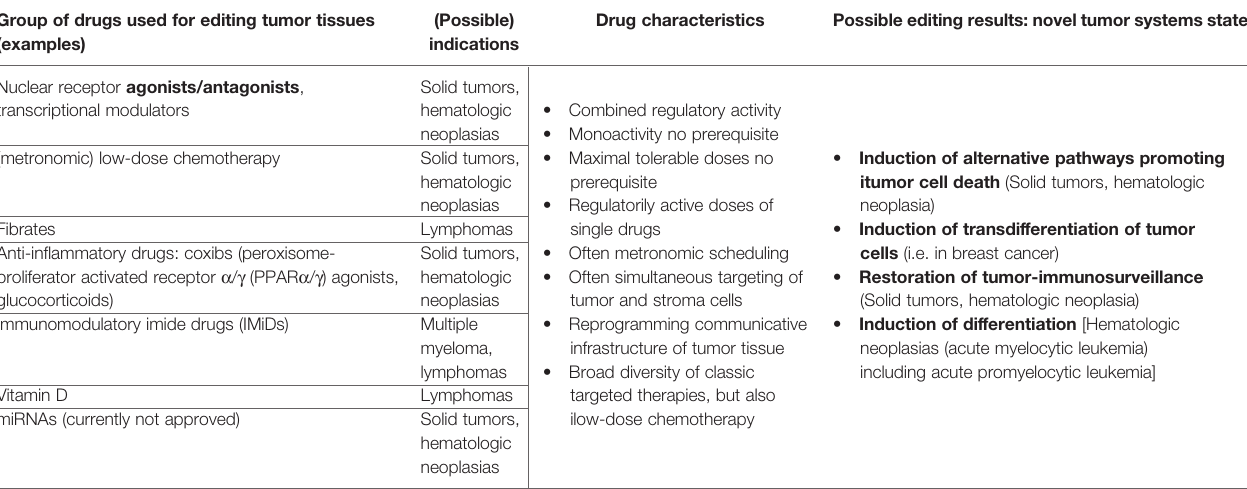
TABLE 1 | Drug repurposing for tumor tissue editing; possible target tumors and substance classes for establishing novel biologic hallmarks facilitating attenuation or resolution of tumor growth. Group of drugs used for editing tumor tissues